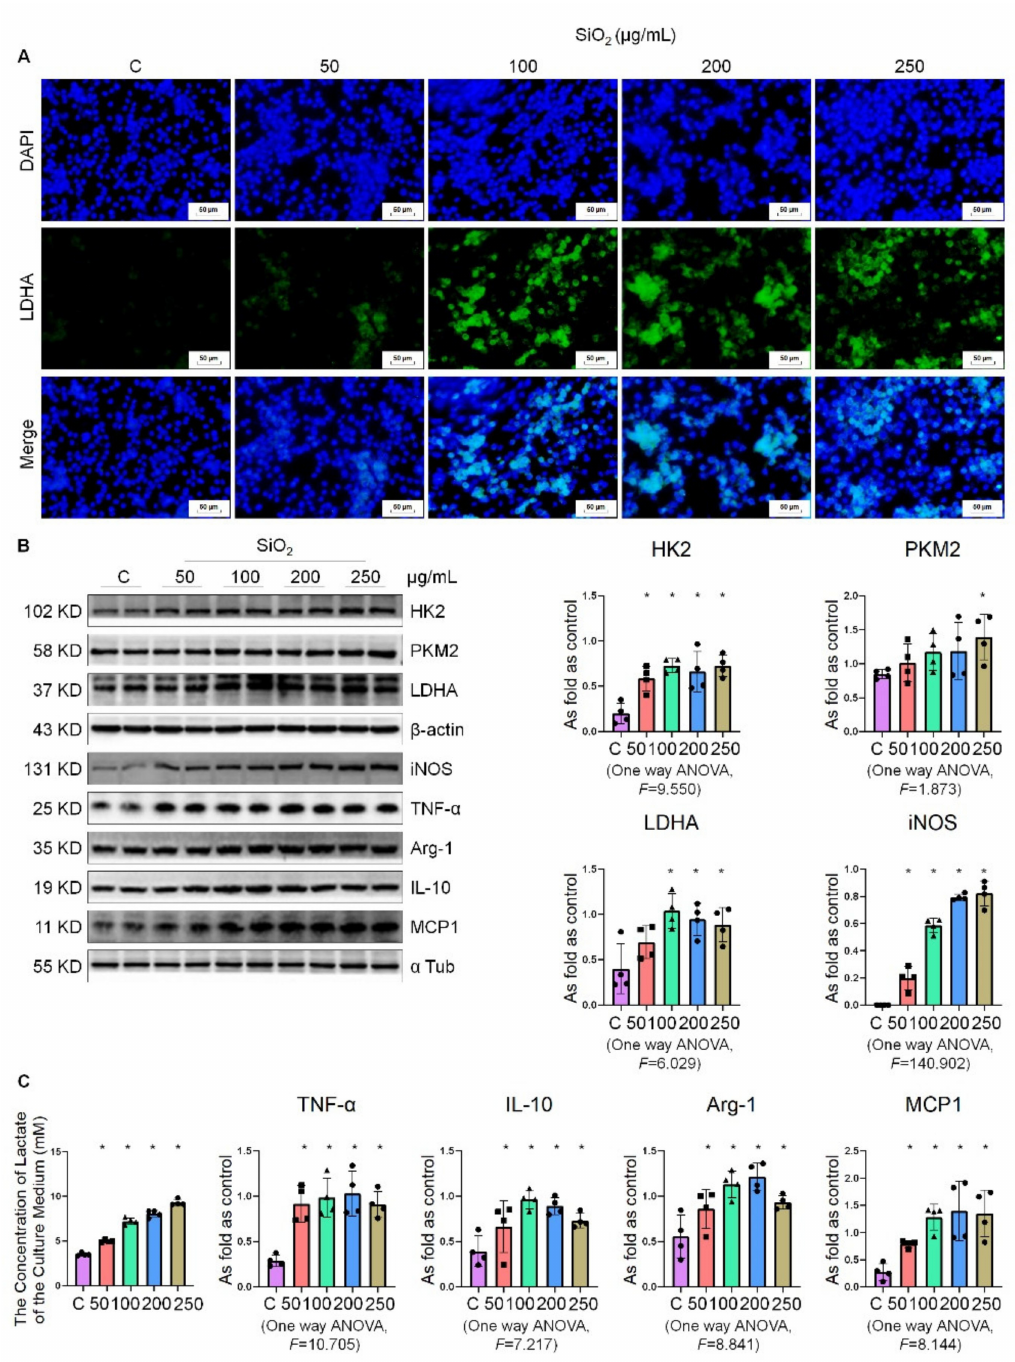
Figure 4. Silica treatment increases the level of glycolysis in macrophages. ( A ) Changes in LDHA expression in NR8383 cells treated with 50, 100, 200, and 250 µ g/mL silica measured by IF staining, bar = 50 µ m. ( B ) Levels of HK2, PKM2, LDHA, iNOS, TNF- α , Arg-1, IL-10, and MCP1 in NR8383 cells treated with 50, 100, 200, and 250 µ g/mL silica measured by Western blotting. * Compared with control group, p < 0.05. Data are presented as the mean ± SD. n = 4 per group. ( C ) The lactate content in the culture medium was detected using a lactate assay kit. *Compared with control group, p <